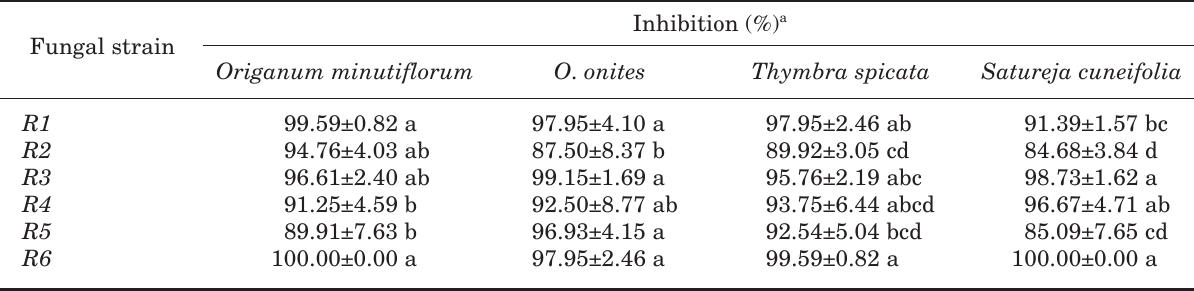
Table 2. Antifungal activity of essential oils of some Turkish herbs ( Origanum minutiflorum, O. onites, Thymbra spicata and Satureja cuneifolia ) tested by the contact assay